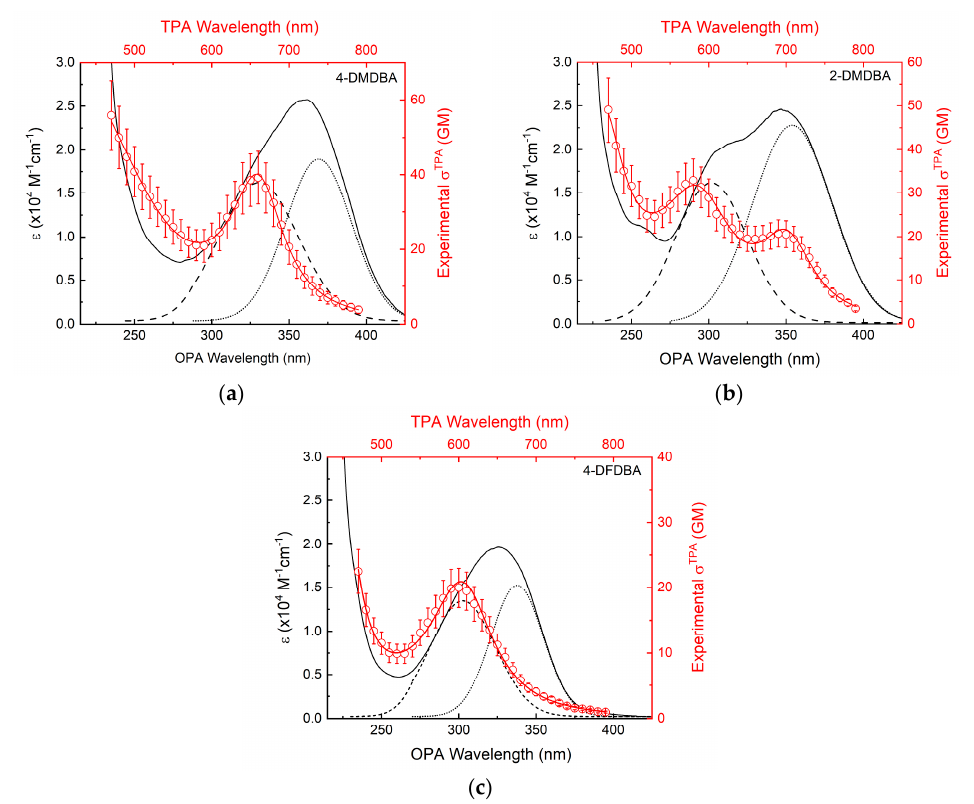
Figure 5. Experimental OPA (black solid lines) and TPA (red circles) spectra of the compounds ( a ) 4-DMDBA, ( b ) 2-DMDBA, and ( c ) 4-DFDBA. The dashed and dotted lines represent the Gaussian decomposition, while the solid red lines correspond to the theoretical fitting obtained with the SOS approach.